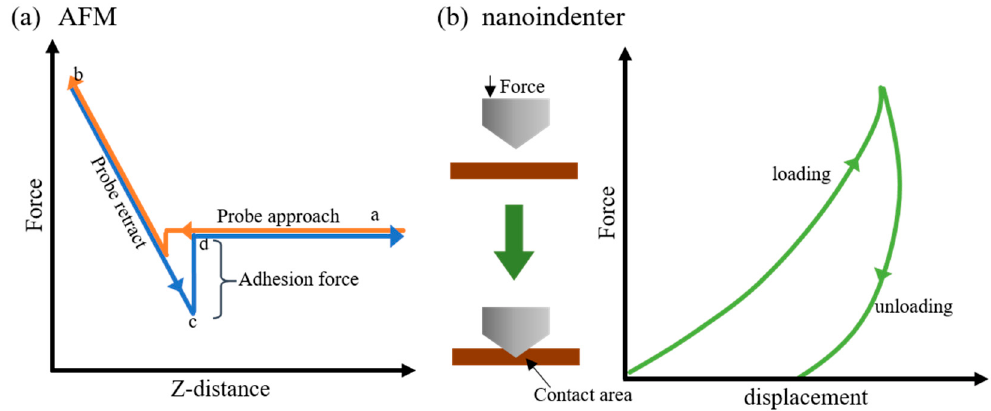
Figure 1. Schematic illustration of ( a ) force–distance curve of AFM and ( b ) force–displacement curve of nanoindenter.